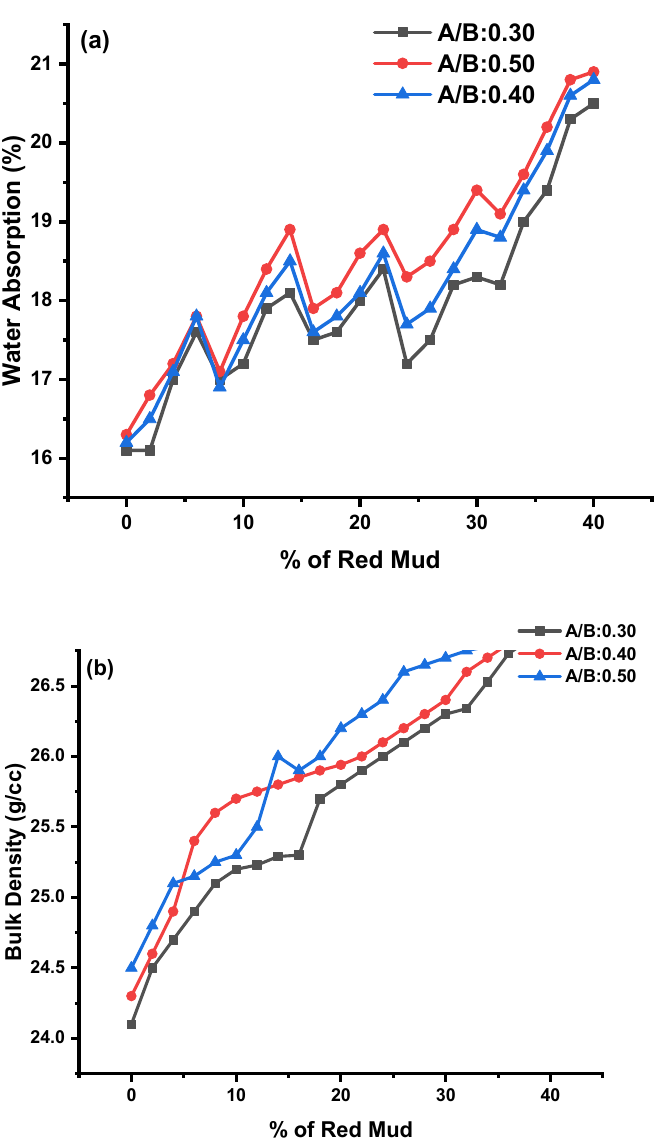
Figure 9. ( a,b ) These represent the WA and BD results for A/B ratios of 0.3, 0.4, and 0.5 for various mixes of GPC, respectively.